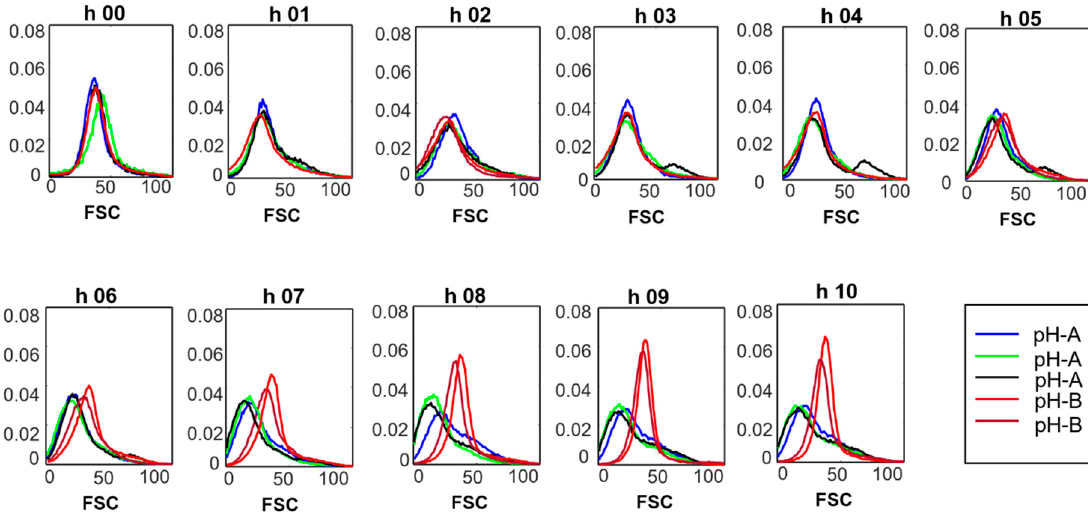
Figure 2. Forward scatter signal (normalized) for samples analyzed every hour during the fermentation.